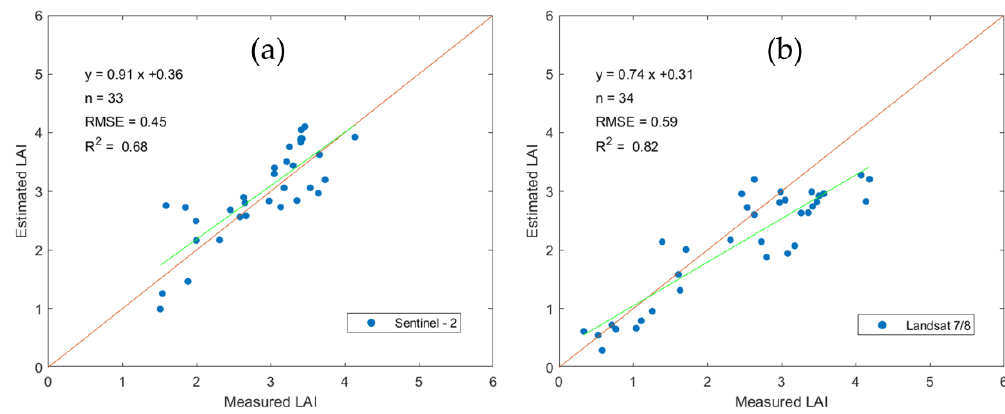
Figure 11. Comparison between measured and estimated LAI (a) derived from Sentinel-2, (b) Landsat 7/8 before DOY (i.e., day of year) 212. (The 1:1 line is shown in red)